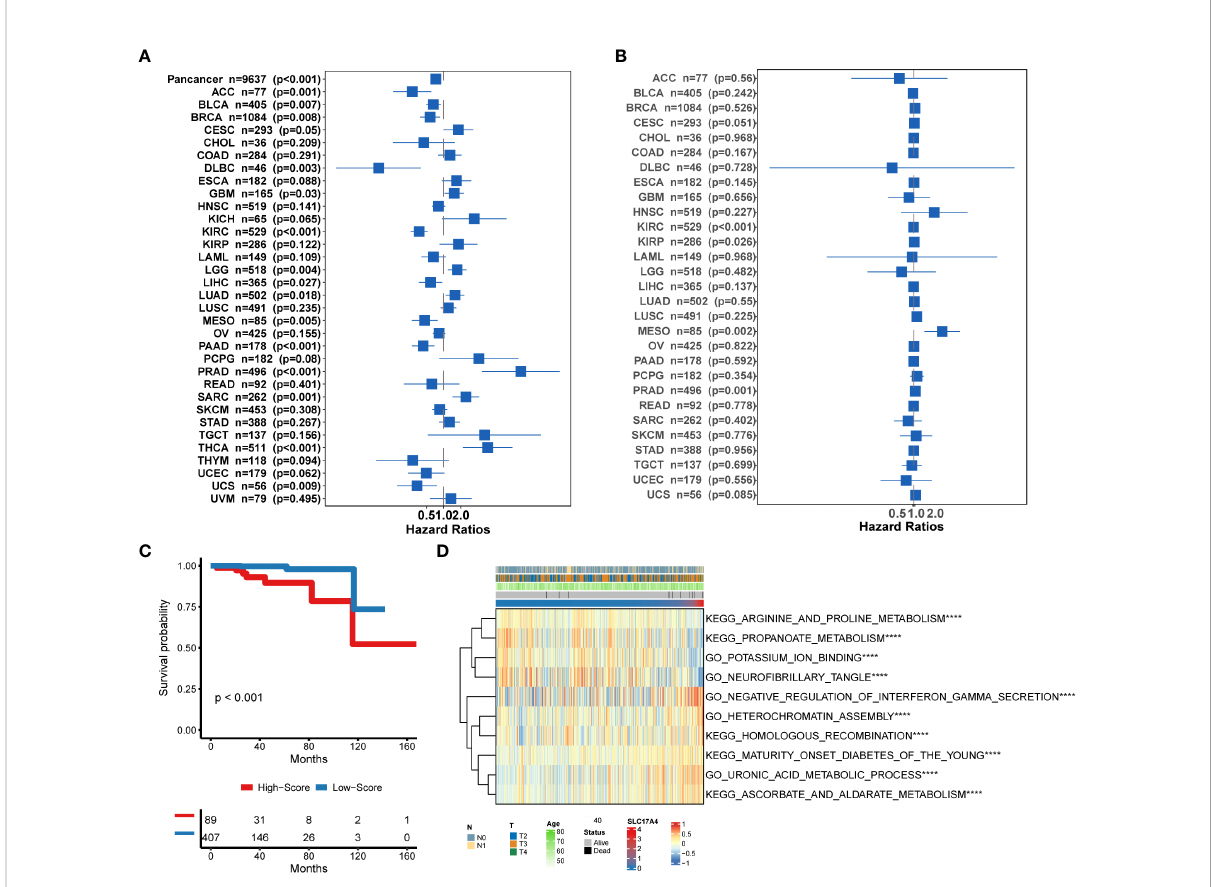
FIGURE 9 (A) Pan-cancer analysis of the 4-gene signature based on TCGA. (B) Correlation between the expression of SLC17A4 and overall survival in multiple tumor types based on TCGA. (C) Survival curves of OS between low-SLC17A4 patients and high-SLC17A4 based on TCGA-PRAD. (D) The differential in GO and Enrich analysis between low- and high-SLC17A4 groups. ****P <